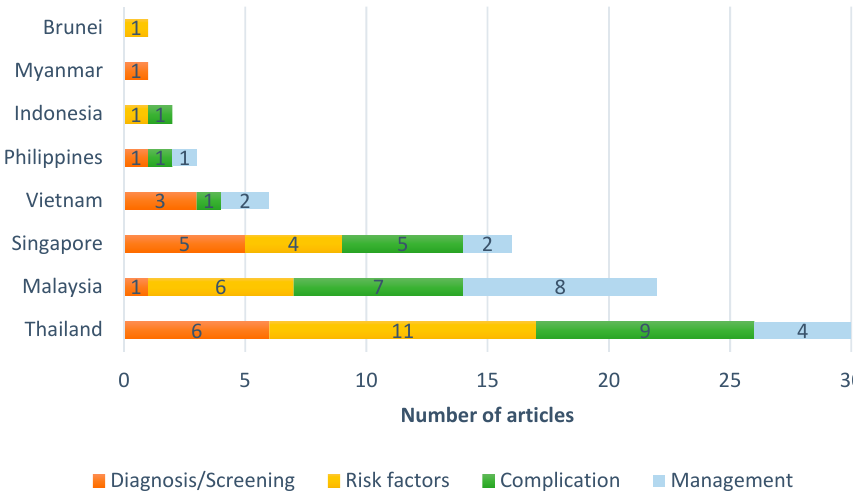
Figure 3. Distribution of articles by geographic location.